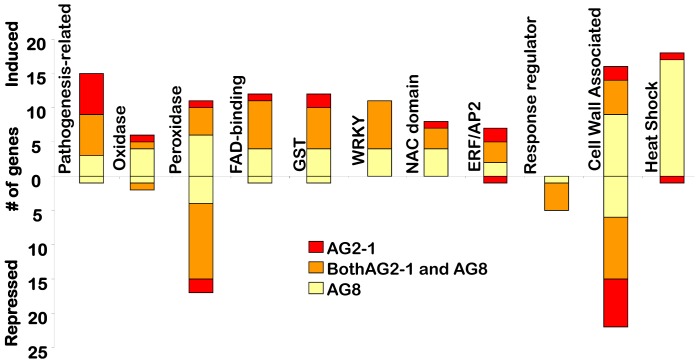
The number of genes affected by AG8 and AG2-1.The number of genes within selected families determine by containing the key words ‘oxidase’ ‘peroxidase’, ‘FAD-binding’, ‘GST’, ‘pathogenesis-related’, ‘ERF/AP2’, ‘NAC domain’, ‘response regulator’, ‘WRKY’, ‘heat shock/protein’ and cell wall identified on the Arabidopsis Affymetrix ATH1 Genome Array that were differentially expressed at P adjusted rate ≤0.05 and induced or repressed by a factor of at least two by R. solani AG8 or AG2-1infection. Of the 236 genes containing the key word ‘ubiquitin’, none were induced or repressed (data not shown). Genes were grouped into ‘cell wall’ criteria based on the program, mapman [50]. In some cases, two or more genes are identified from each array element name, and these are depicted as one gene.